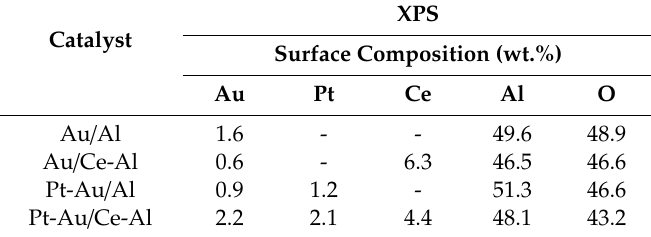
Table 3. Surface composition of the Au-containing